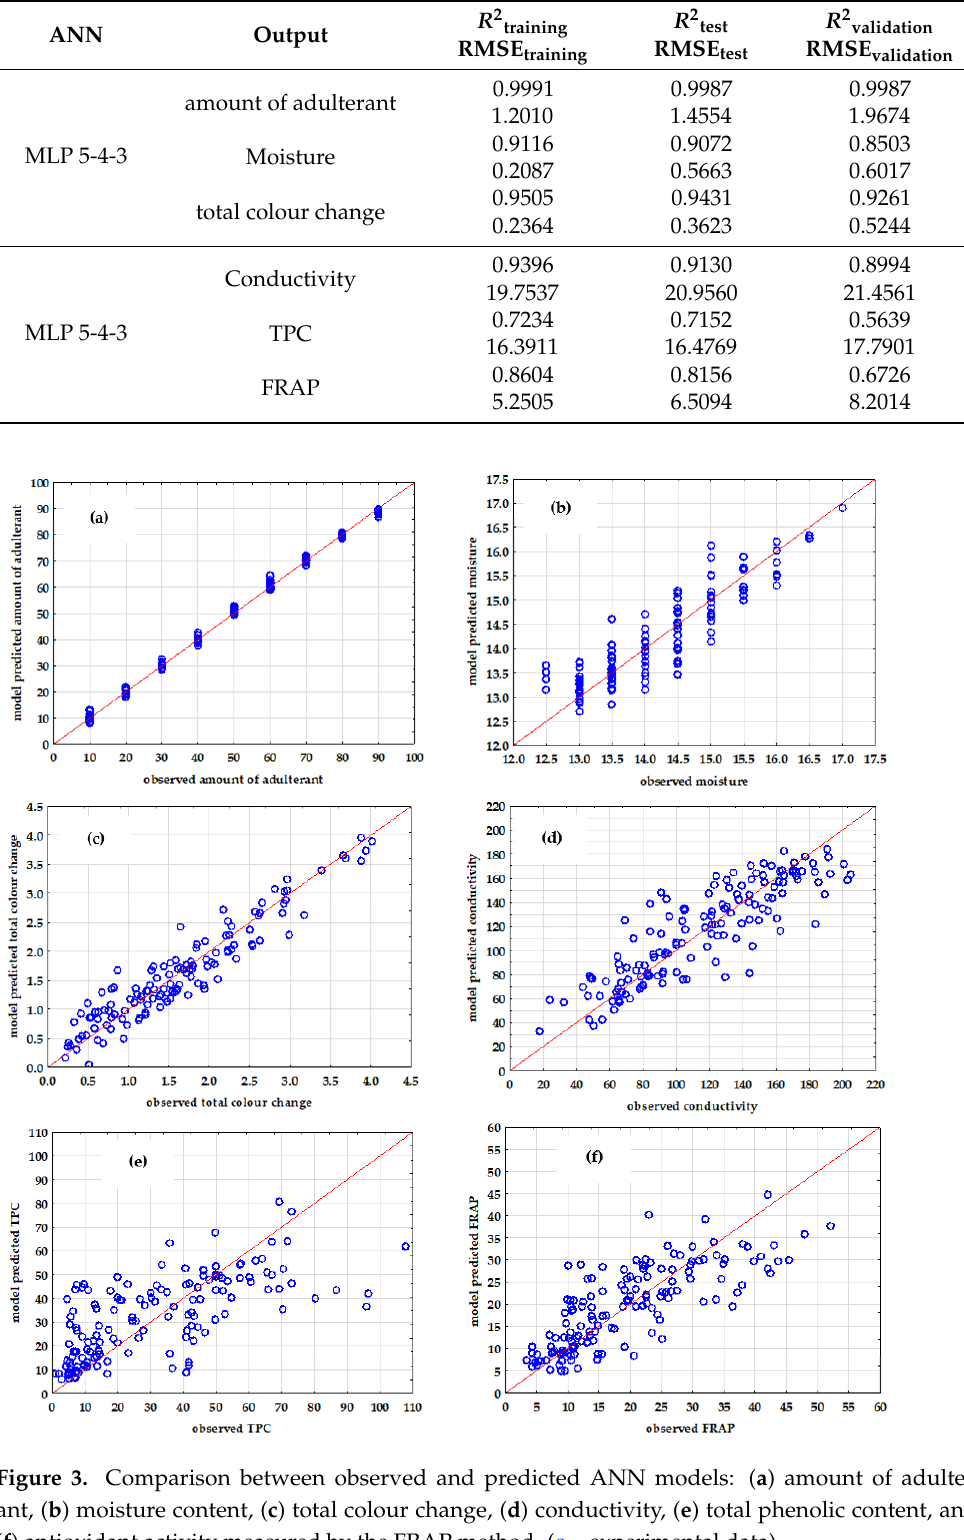
Table 3. Correlation coefficients of ANN models.